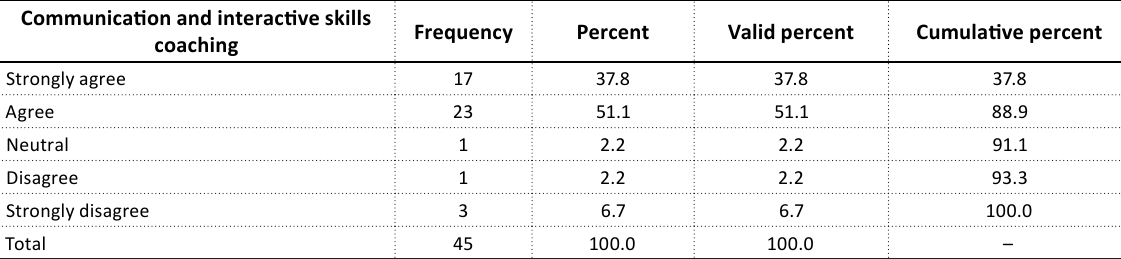
Table 4. Frequency showing the communication and interactive skills coaching Communication and interactive skills coaching